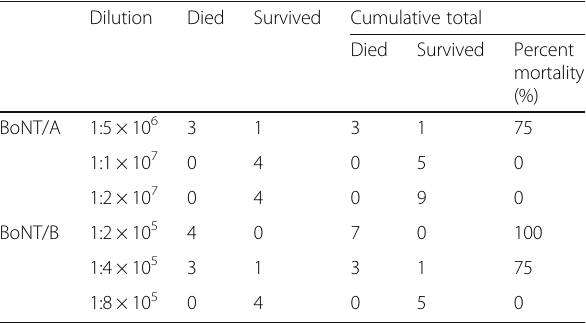
Fig. 4 The determination of the optimal digestion time of the LFTS.